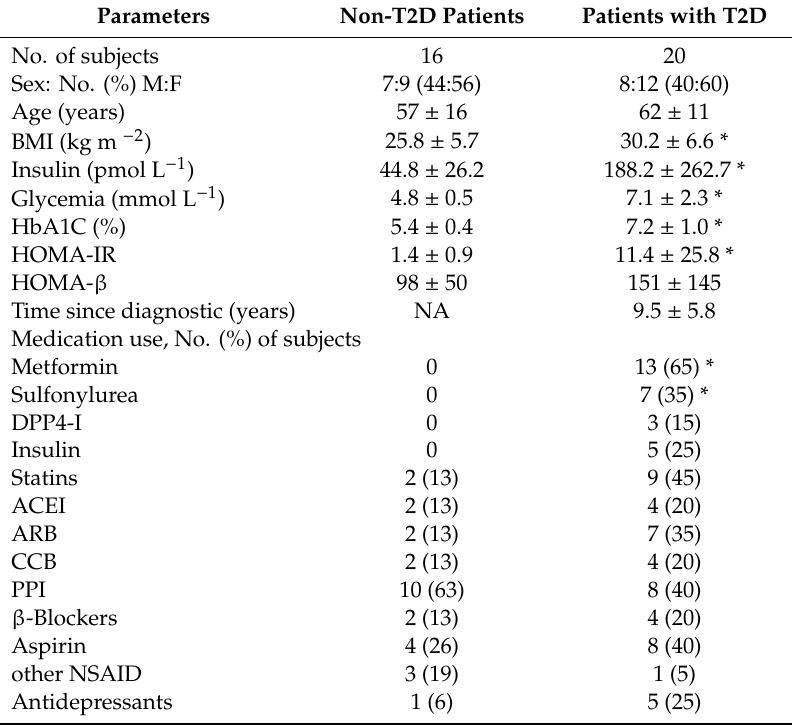
Table 1. Baseline demographic data and clinical characteristics of